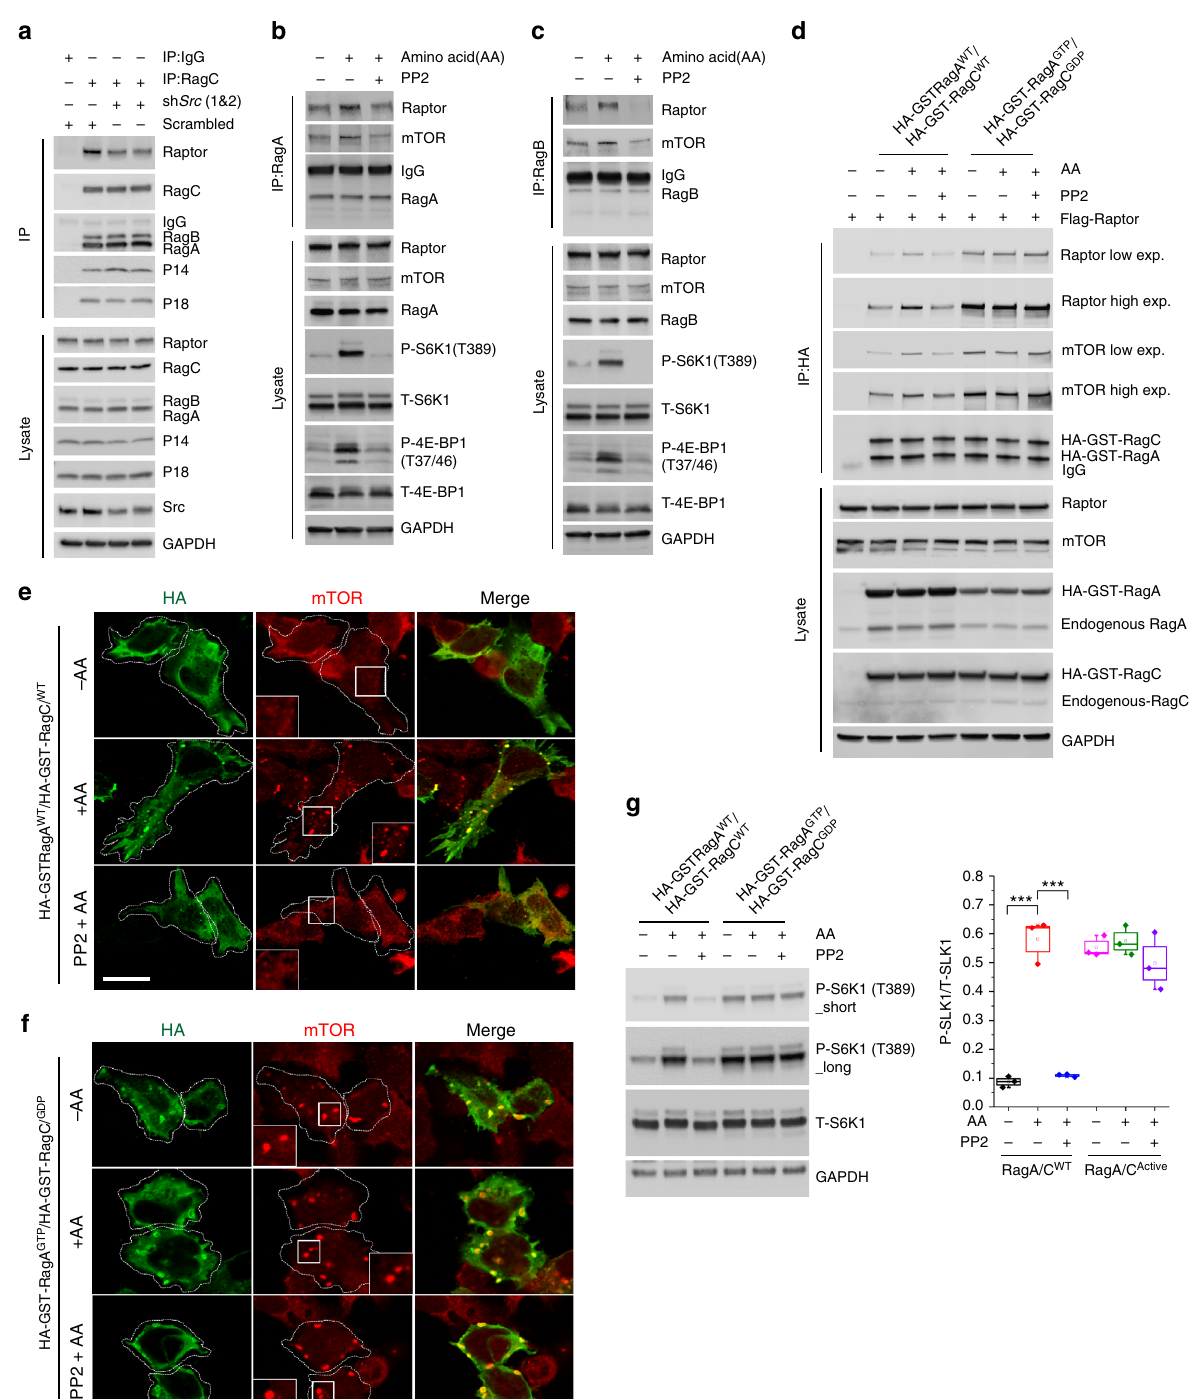
them and initiates GTP-loading of RagA/B via inhibition of GATOR1 14,15 . It is possible that GATOR2 transfers the amino acid signal to Src, which then initiates GTP-loading of RagA/B by dissociating Rag – GATOR1 interaction. GATOR2, once released from sestrin2 or CASTOR1, might interact with Src and lead to a conformational change that activates Src thus enabling dissocia- tion of GATOR1 from the Rags. Future studies that investigate the molecular association between GATOR2 and Src could establish whether this mechanism funnels so far unidenti fi